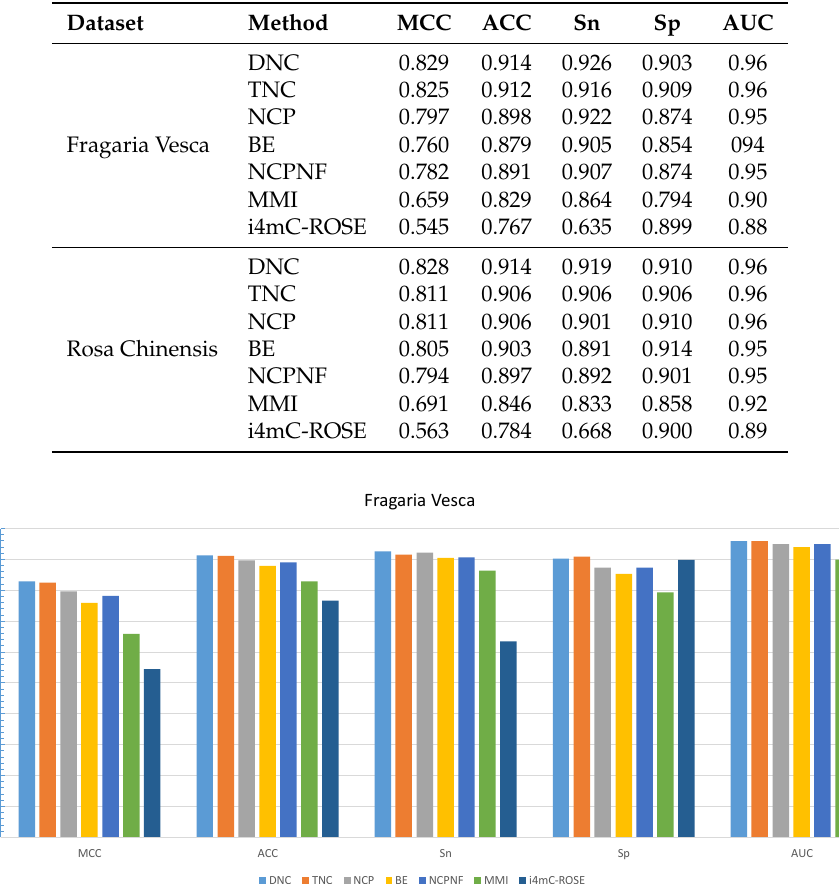
Table 4. Performance evaluation of six encoding methods with state-of-the-art model on training benchmark dataset for F. vesca and R. chinensis species.